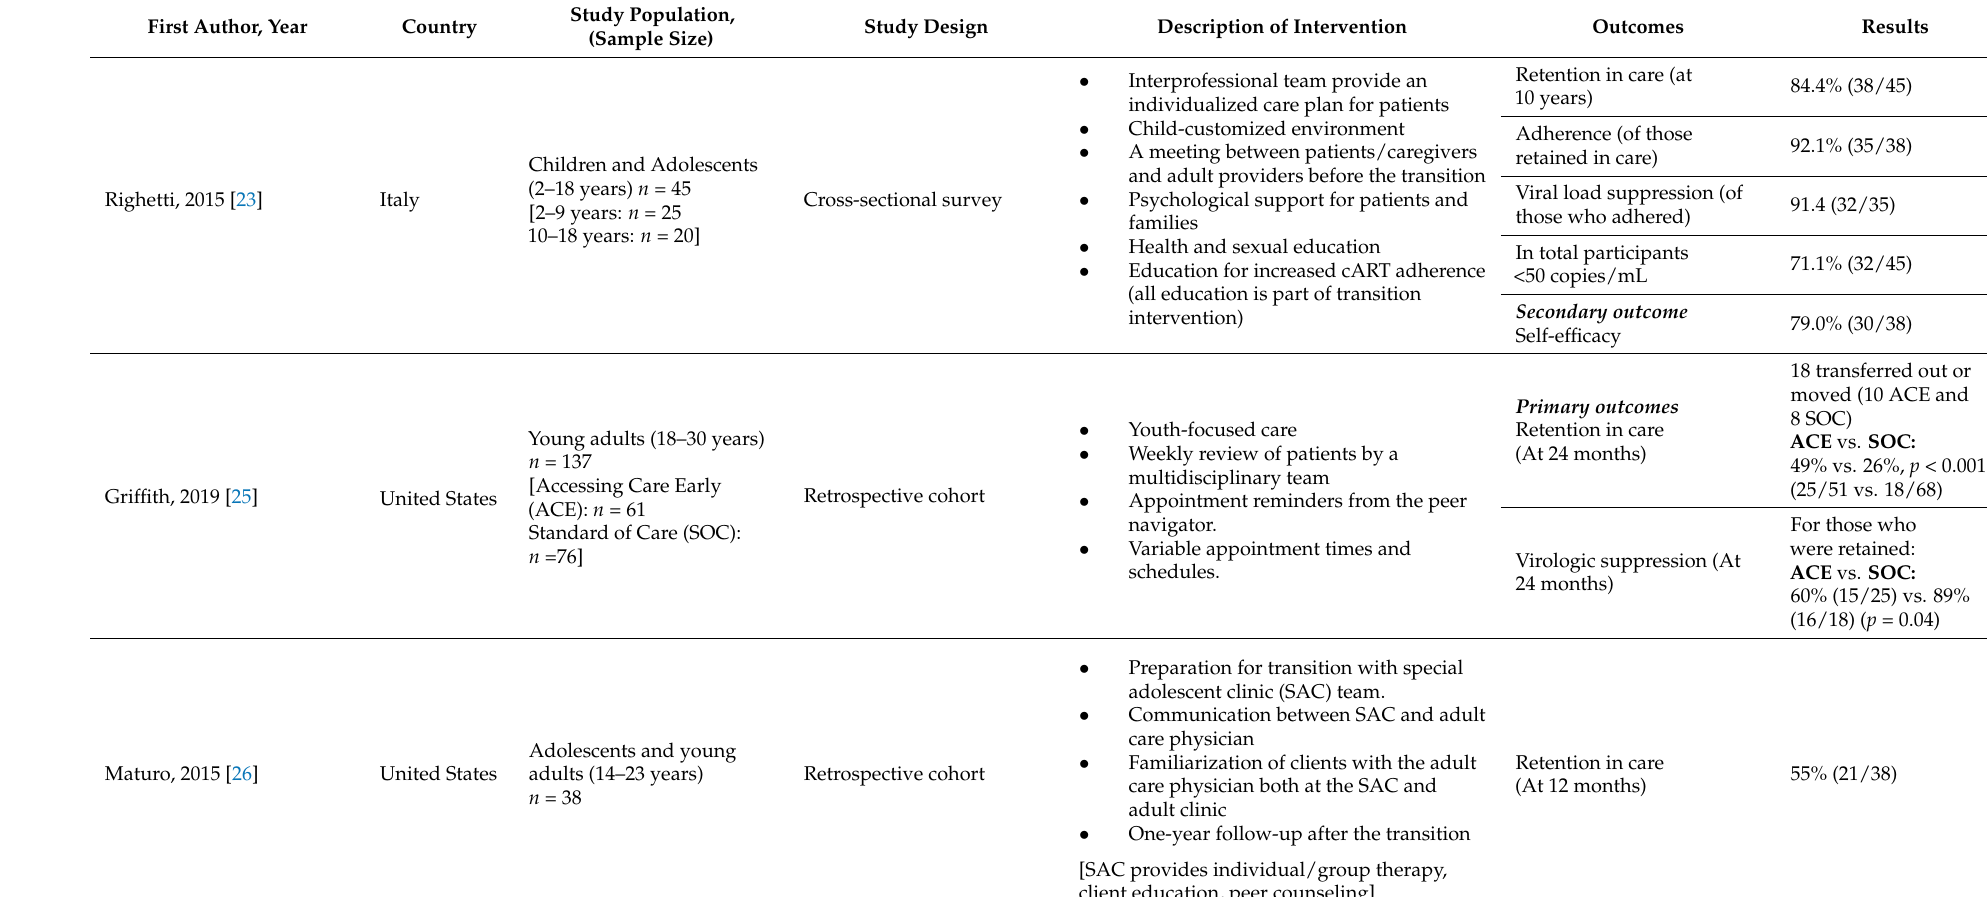
Table 2. Five studies used a cohort study design [24–26,28,29] and two were cross-sectional surveys [23,27]. The sample sizes ranged from small (13) to moderate sample size